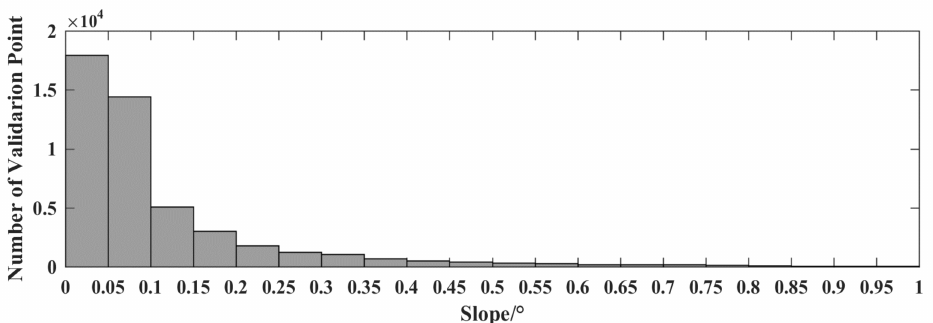
Figure 15. Number of OIB airborne points used to ICESat-2 FRIS DEM evaluation. The horizontal coordinate is the slope of the surface from 0 ◦ to 1 ◦ with an interval of 0.05 ◦